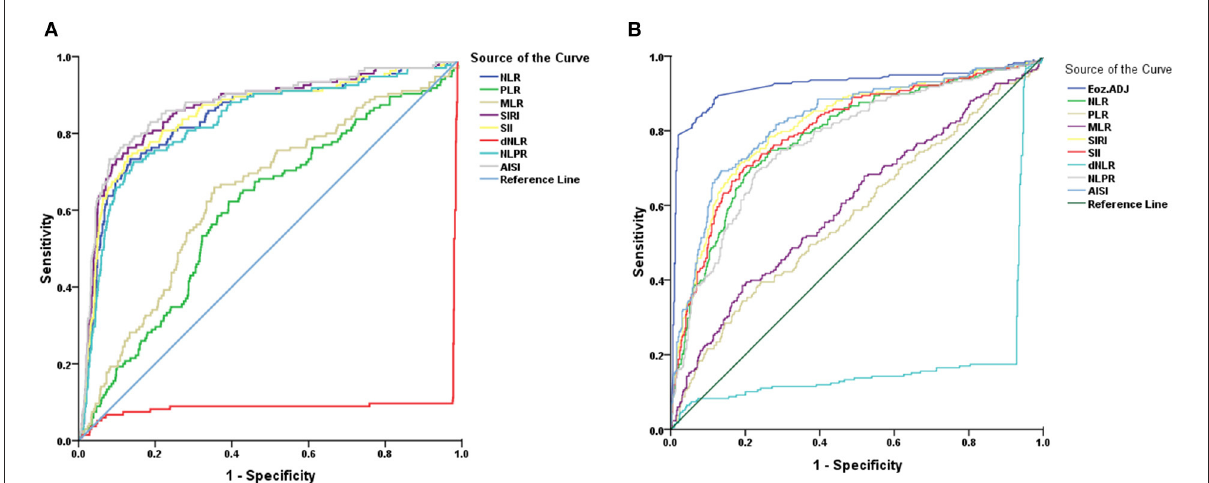
FIGURE1 Receiver operating characteristics curve of (A) Non-elderly patients and (B) Elderly patients for NLR, PLR, MLR, dNLR, NLPR, AISI, SIR-I, and SII. AISI, aggregate index of systemic inflammation; dNLR, derived neutrophil/lymphocyte ratio; MLR, monocyte/lymphocyte ratio; NLPR, neutrophil/lymphocyte*platelet ratio; NLR, neutrophil/lymphocyte ratio; PLR, platelet/lymphocyte ratio; SII, systemic inflammation index; SIR-I, systemic inflammation response